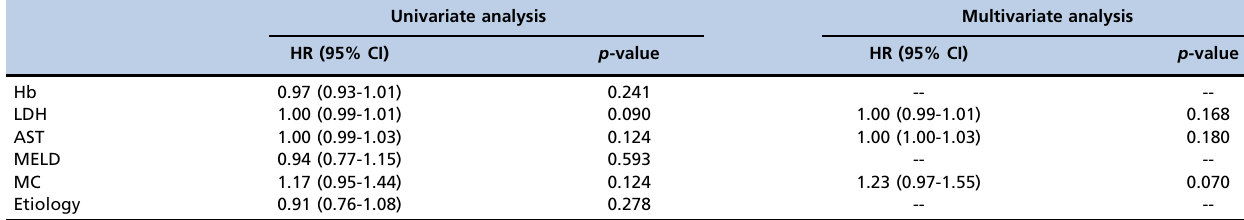
Table 3 - Association between clinical and laboratorial parameters and EFS